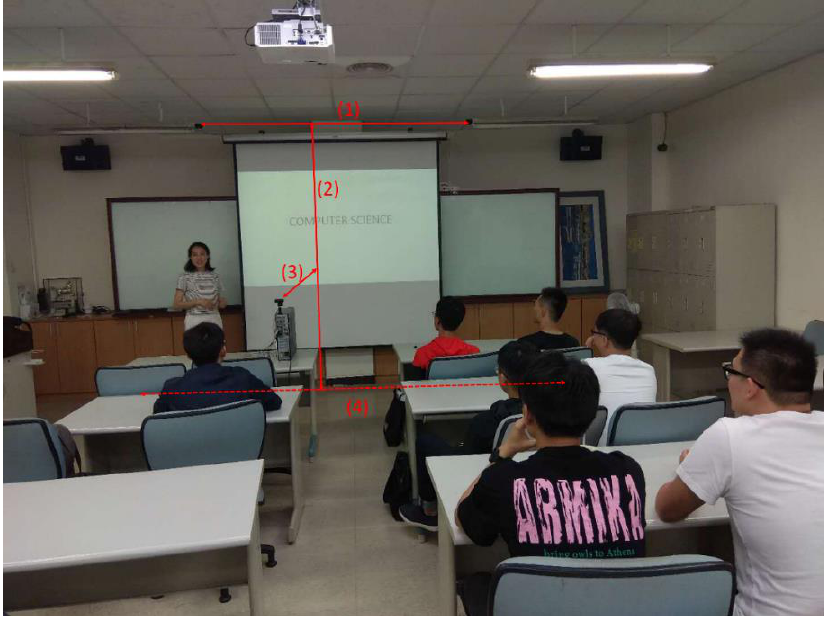
Figure 6. One of the experimental scenarios.